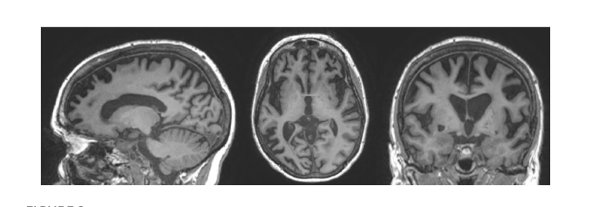
FIGURE 2 MRI images of the proband at evaluation. Portrayed are representative images from a T1-weighted sequence indicating severe global atrophy, slightly right > left, most pronounced in frontal, temporal, and parietal regions, and deemed consistent with behavioral variant frontotemporal